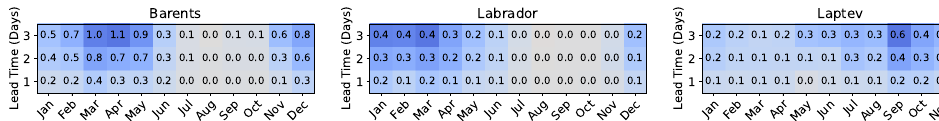
Figure 14. JAXA SIC MAE averaged over 3 forecast days and over all of 2021 for different ablations of general U-Net (R) configuration with GFS. From left to right on each diagram, we first turn on augmentations and then add persistence base to the predictions (as in Equation (5)) and report the model’s metric.